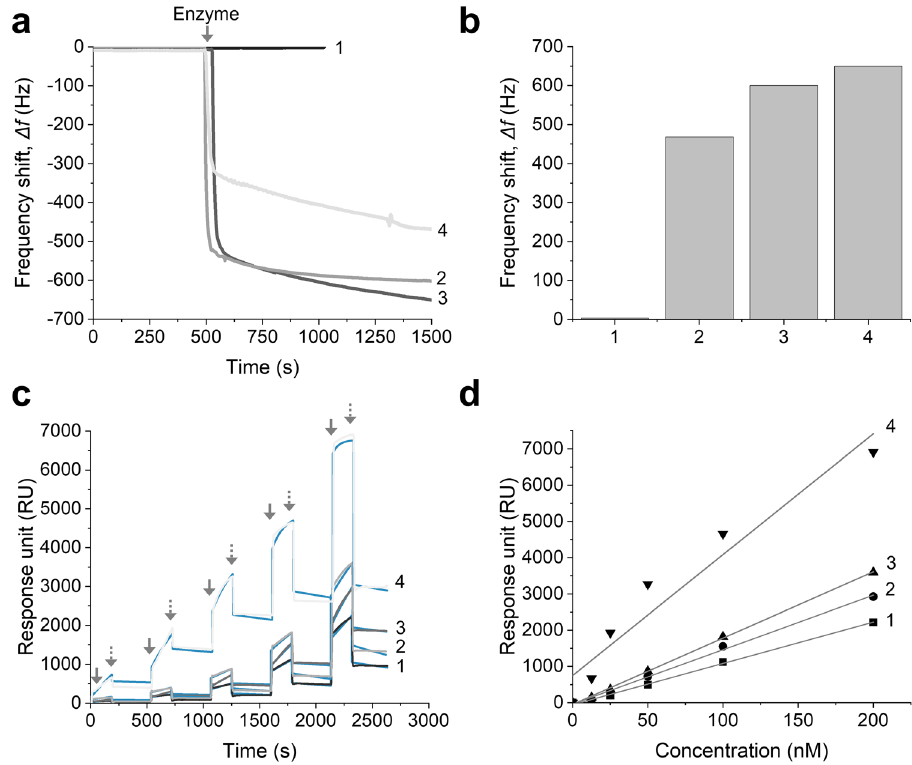
Fig. 5 Gold-binding properties of the native and synthetic enzymes. a Gold-binding activities of the native CODH-L and of the synthetic constructs as determined by QCM analysis (the arrow indicates the injection of 1 µ M enzyme solution). b Comparison of the frequency shift in a . c Changes in the SPR refractive index as a function of time for enzyme adsorption on the gold surface at enzyme concentrations of 12.5, 25, 50, 100, and 200 nM (the solid arrows indicate enzyme injection while the dashed arrows indicate buffer injection). The blue traces represent the global fi t of the data to a 1:1 binding model. d Titration curve obtained from plotting the binding response against the enzyme concentration. Key: 1, 2, 3, and 4 refer to CODH-L, CODH-L gbpN , CODH-L gbpC , and CODH-L gbpNC ,